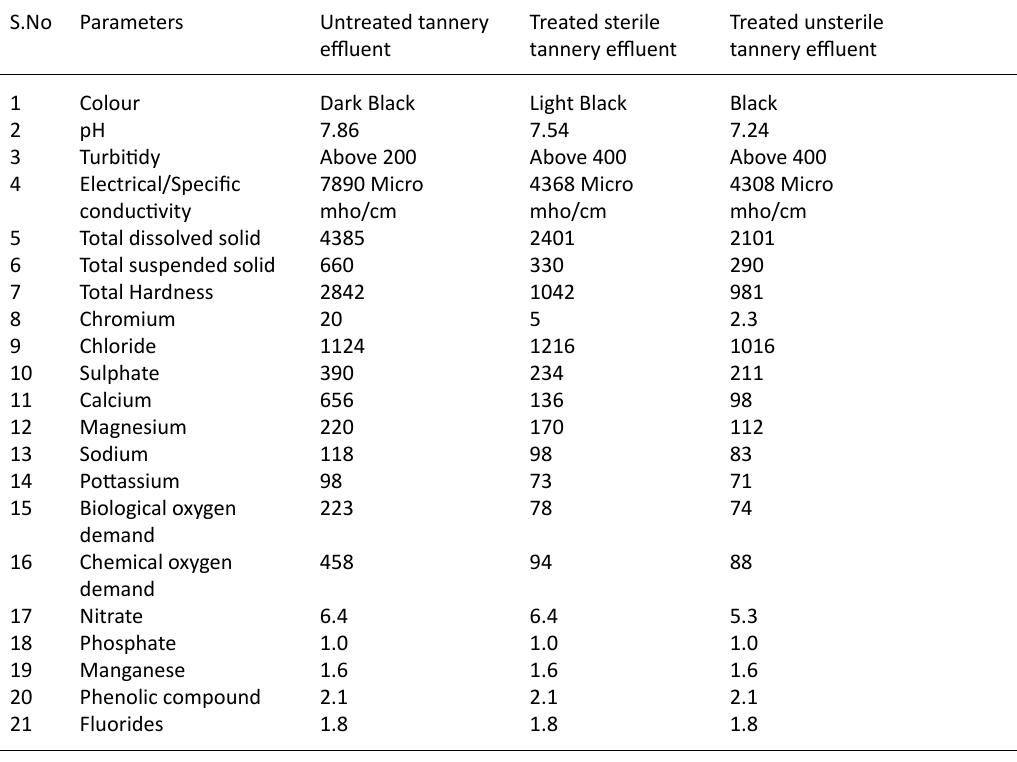
Fig. 6. Bioreduction of chromium contaminated tannery effluent through lab scale bioreactor Table 1. Physico-chemical parameters of untreated tannery effluent, treated sterile tannery effluent and treated unsterile tannery